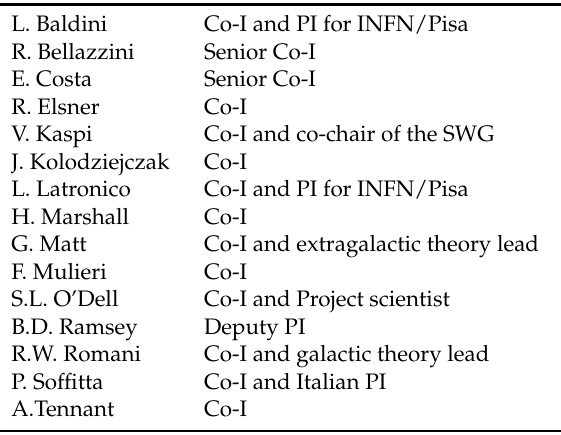
Figure 11. Schematic rendering of IXPE deployed with the major elements identified. Table 1. IXPE co-Investigators and